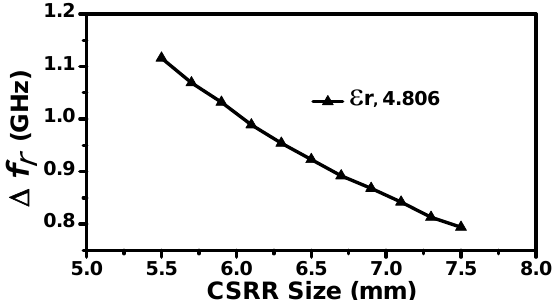
Figure 2. The sensitivity of a single CSRR (represented by a shift in the resonance frequency) as a function of the CSRR’s dimension when loaded with a dielectric slab having a relative permittivity of 4.8.